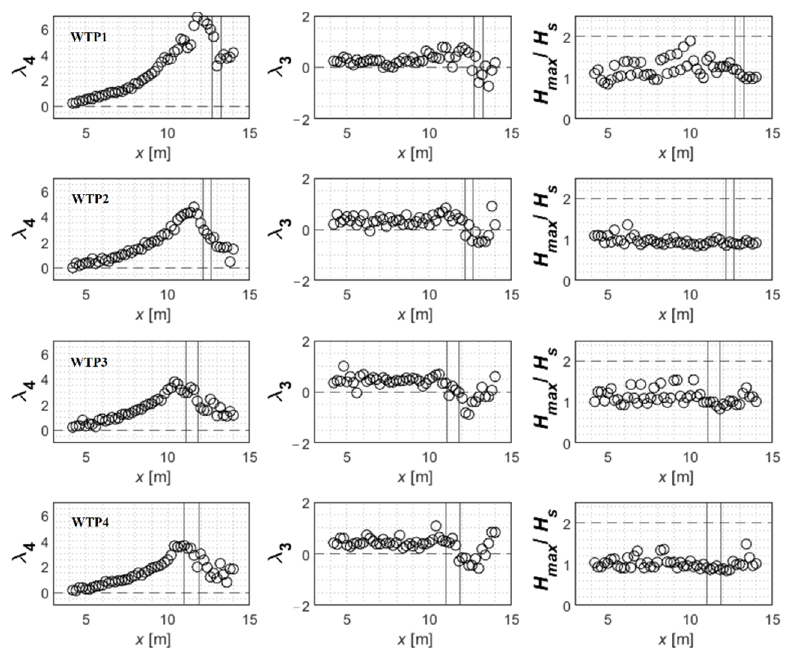
Figure 4. The spatial evolution of λ 4 , λ 3 and H max / H s for the four studied Pierson–Moskowitz wave trains.